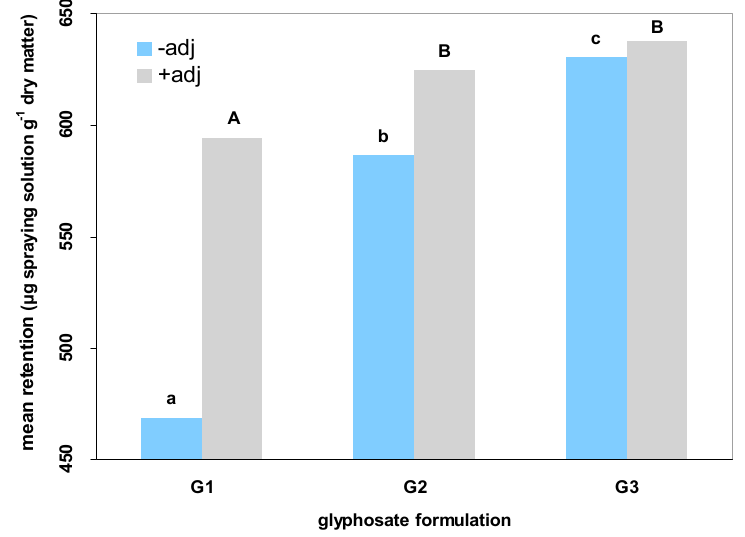
Figure 3. Interaction plot showing mean retention of spraying solution on C. sumatrensis leaves according to glyphosate formulation both in the absence or after addition of adjuvant (either adj1 or adj2). Within each adjuvant level, different letters indicate significant differences between formulations according to a Kruskal–Wallis test and post hoc level comparisons based on a Wilcoxon test with Bonferroni correction for multiple testing (adjuvant addition, +adj) or to a one-way ANOVA using contrasts for level comparisons (absence of adjuvant, − adj).